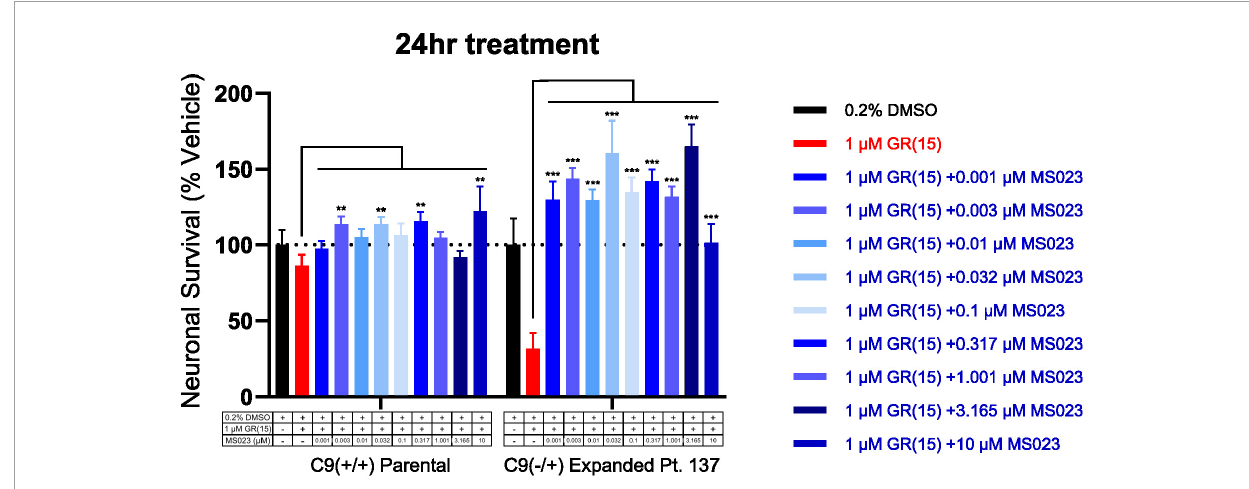
FIGURE5 Protein arginine methyltransferase inhibition rescues polyGR 15 -induced toxicity in C9orf72-expanded motor neurons. Survival of spinal motor neurons 24 days post-plating following co-treatment with 1 µ M polyGR 15 and concentrations of MS023 ranging from 1 nM to 10 µ M. **Denotes p < 0.01, and ***denotes p < 0.001 (comparing MS023 co-treated groups to polyGR 15 alone by two-way ANOVA analysis of variance followed by Dunnett’s test). Data are presented as mean values ± standard deviations (error